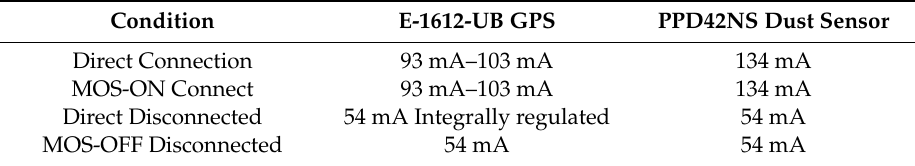
Table 1. Selected voltage characteristics of GPS and dust sensors